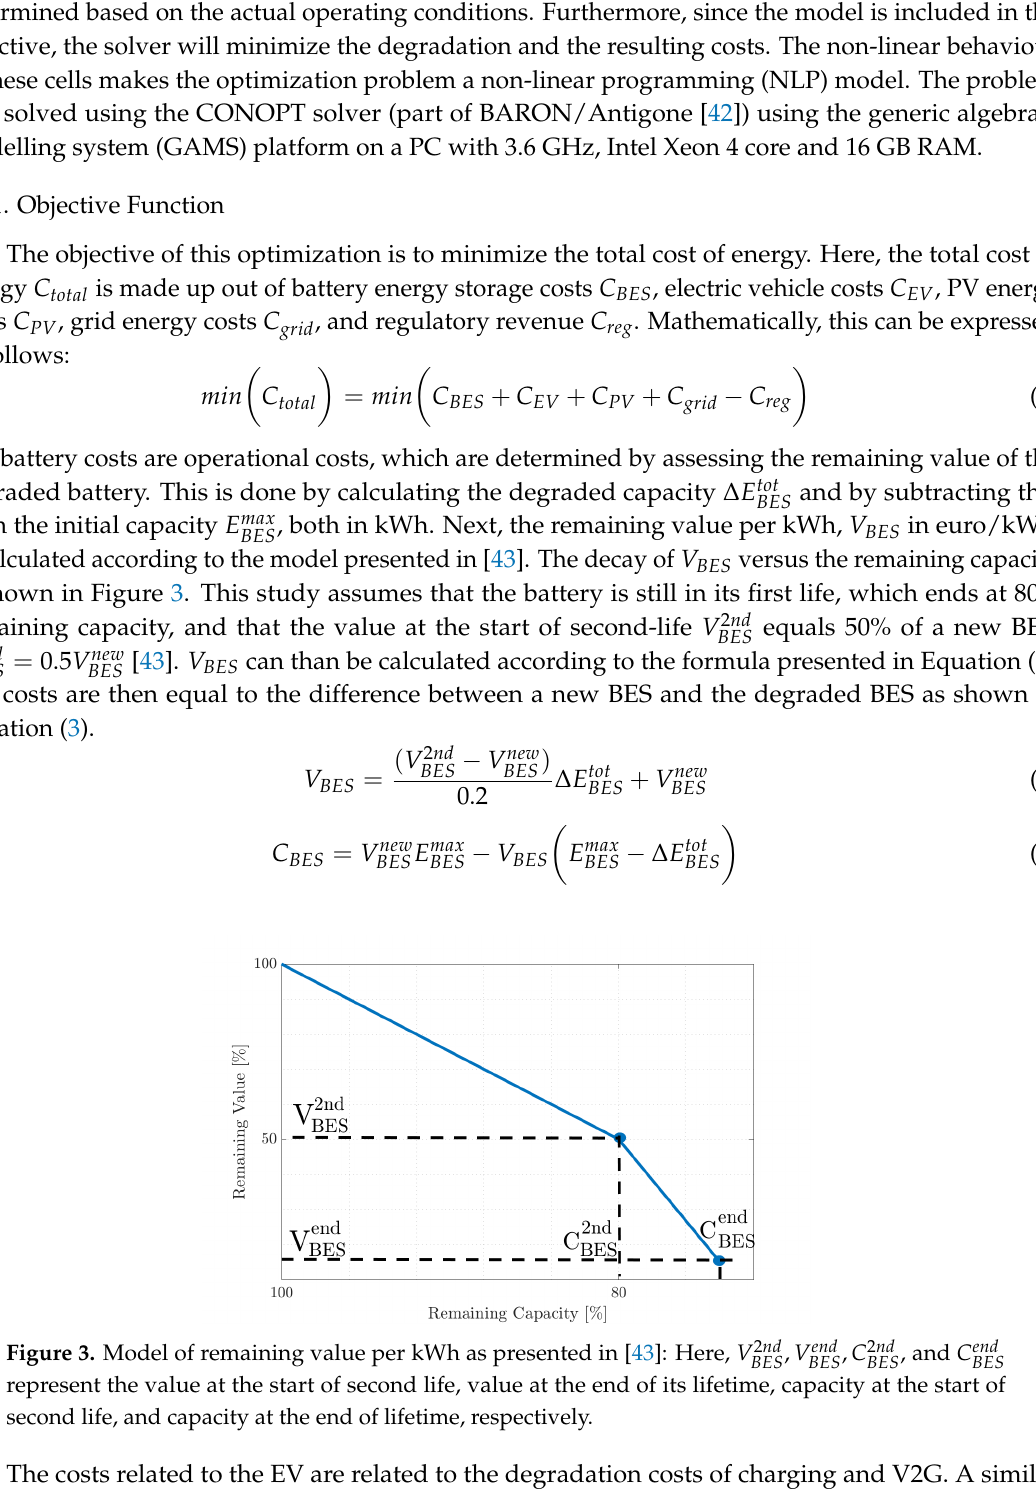
, V end , C 2 nd , and C end BES BES BES BES